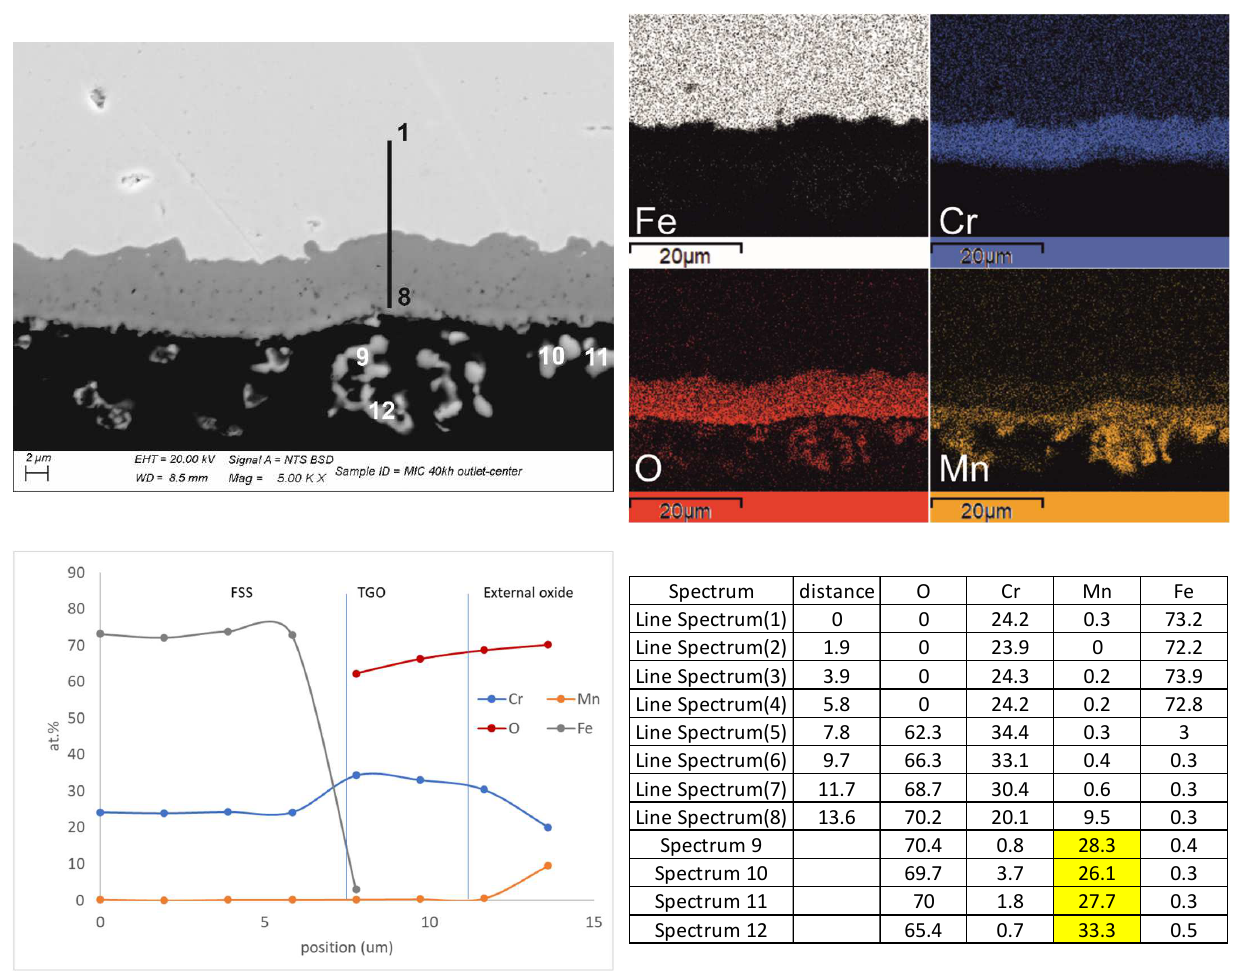
Figure 8 . Quantitative line profile (spectra from 1 to 8 along the black line) and elemental X-ray mapping with a related original micrograph and table showing the increase in Mn content and decrease in Cr content from the metal substrate to the external oxides. Analyses from 9 to 12 were acquired on the external layer only. The highlighted values show that the average content of Mn is close to 30 at. % therefore related to the MnO 2 stoichiometry.